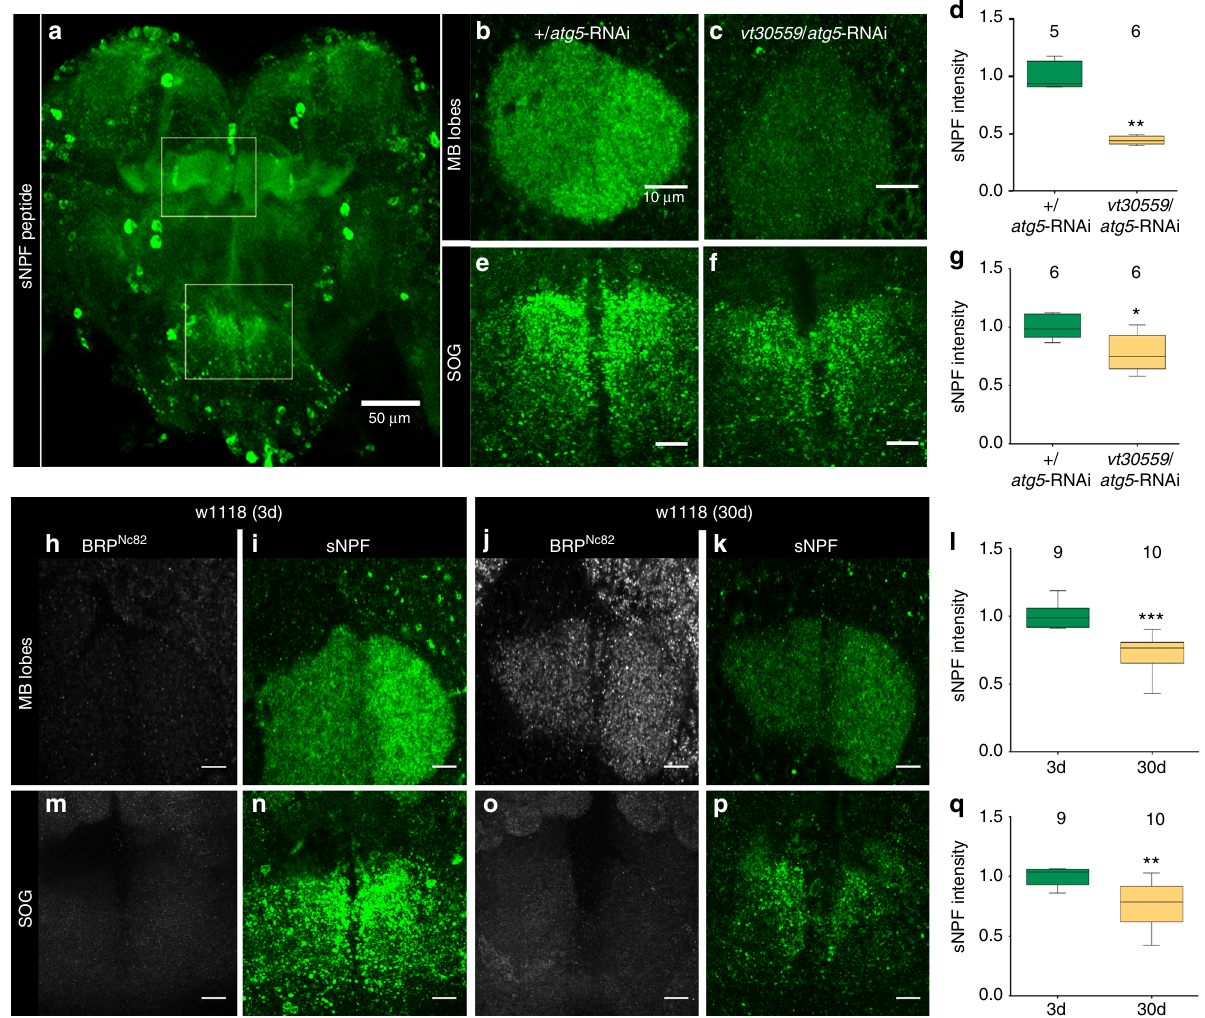
Fig. 5 sNPF levels decline with mushroom body-speci fi c attenuation of autophagy and with aging. a Adult brain immunostained for sNPF-precursor. Scale bar: 50 μ m. b MB lobes of + / atg5 -RNAi and c vt30559 / atg5 -RNAi immunostained for sNPF precursor (Single Z-plane). Scale bar: 10 μ m. d Quanti fi cation of signal intensity of sNPF peptide precursor in the MB lobes normalized to control fl ies (5 – 6 independent animals; ** p < 0.01; Mann – Whitney U -test). e Subesophageal ganglion (SOG) of + / atg5 -RNAi and f vt30559 /atg5-RNAi immunostained for sNPF precursor (Z-projection). Scale bar: 10 μ m. g Quanti fi cation of signal intensity of sNPF-peptide precursor in SOG normalized to control fl ies ( n = 6 independent animals; * p < 0.05; Mann – Whitney U - test). MB lobes of ( h ) 3-day-old w1118 and ( j ) 30-day-old w1118 immunostained for BRP Nc82 (single Z-plane). Scale bar: 10 μ m. MB lobes of ( i ) 3-day-old w1118 and ( k ) 30-day-old w1118 immunostained for sNPF (Single Z-plane). Scale bar: 10 μ m. l Quanti fi cation of signal intensity of sNPF peptide precursor in the MB lobes normalized to control fl ies (9 – 10 independent animals; *** p < 0.001; Mann – Whitney U -test). SOG of ( m ) 3-day-old w1118 and ( o ) 30-day-old w1118 immunostained for BRP Nc82 (Single Z-plane). Scale bar: 10 μ m. SOG of ( n ) 3-day-old w1118 and ( p ) 30 days w1118 immunostained for sNPF